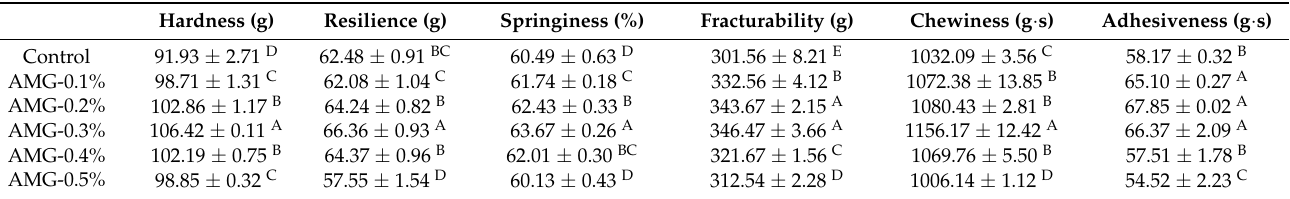
Table 4. Textural properties of frankfurters with or without AMG at different